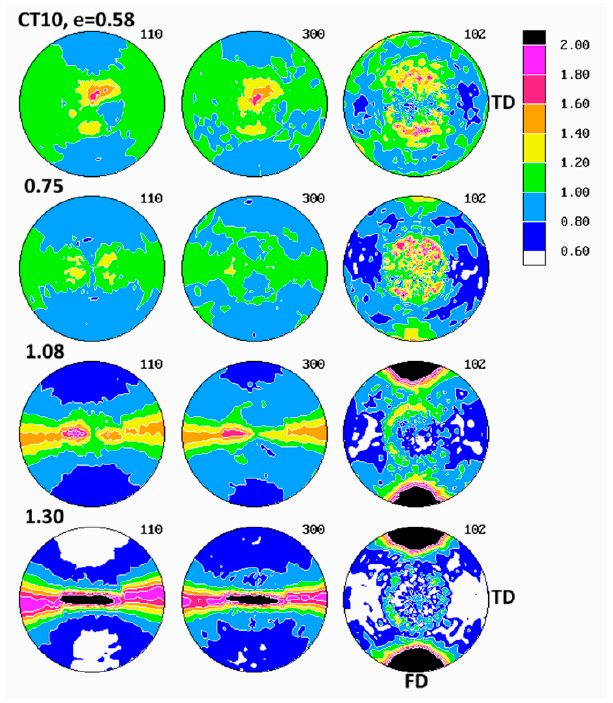
Figure 15. Selected pole figures of the (110) (300) and (102) crystallographic planes (Form I) determined for samples of C10 copolymer drawn in uniaxial tension to the true strain indicated.